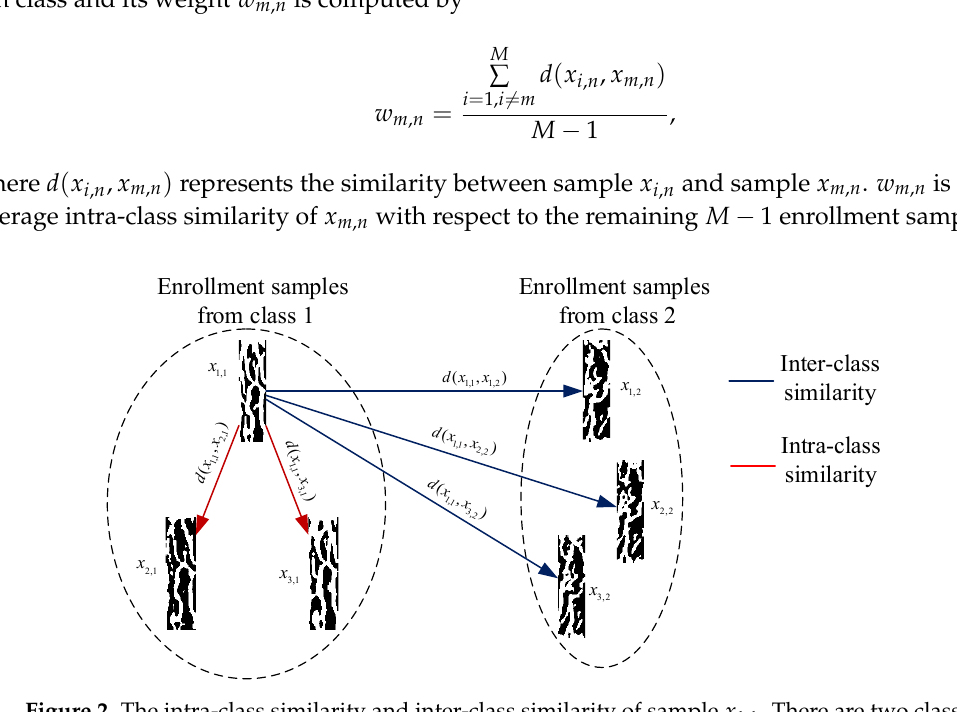
Figure 2. The intra-class similarity and inter-class similarity of sample x 1,1 . There are two classes and each class provides three enrollment samples. The red arrow implies that the similarity is computed based on two images from same class and the blue arrow implies that the similarity is computed based on two images from different